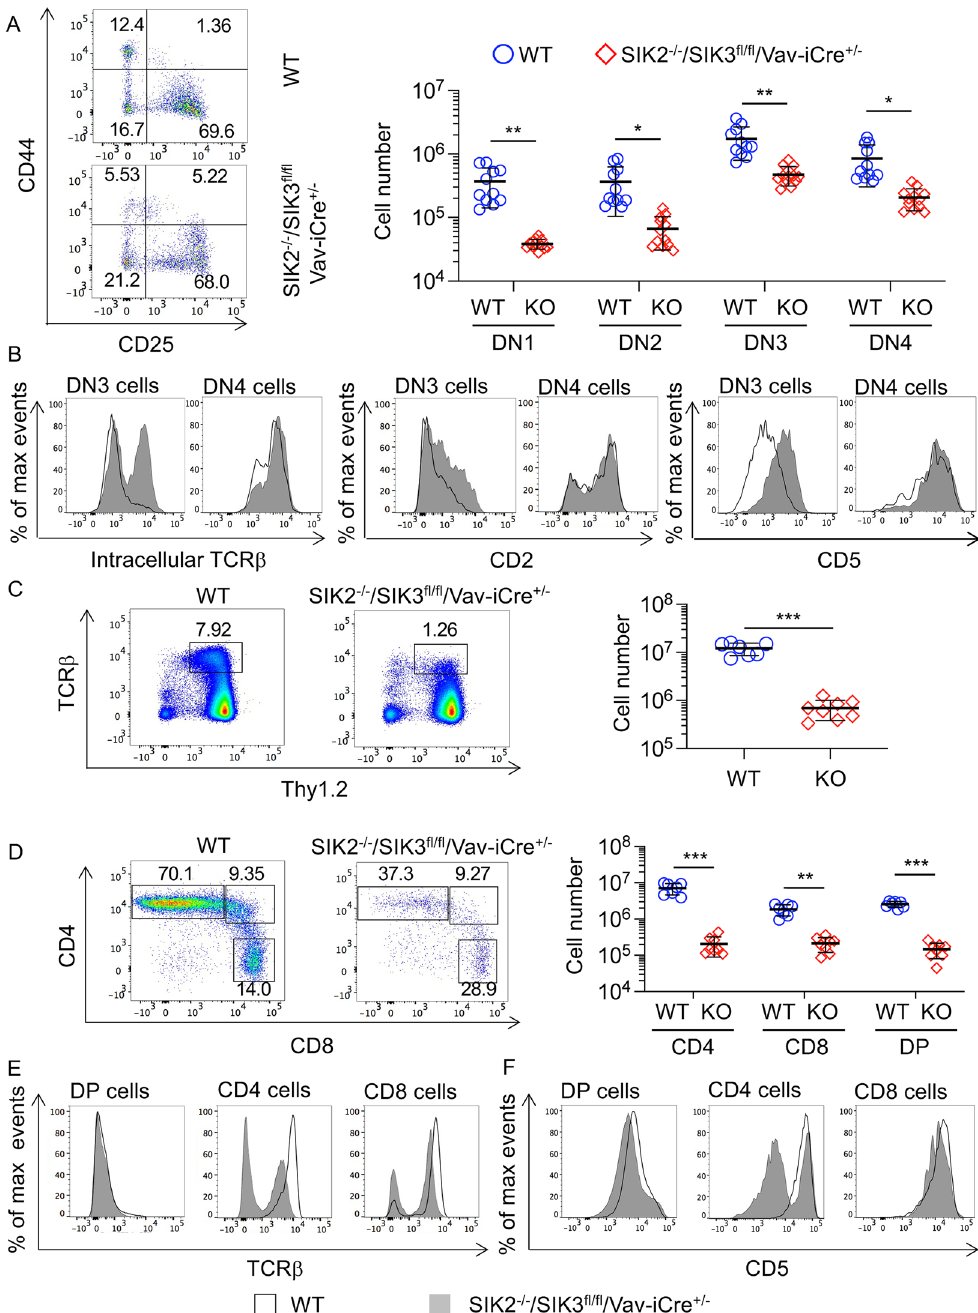
Figure 6. Thymic T cell development is compromised in SIK2 -/- /SIK3 fl/fl /Vav-iCre +/- mice. Thymi were isolated from wild type (WT) and SIK2 -/- /SIK3 fl/fl /Vav-iCre +/- (KO) mice and analysed by flow cytometry. To identify DN cell subsets, Thy1.2 +ve CD4 -ve CD8 -ve cells were gated and analysed for CD25 and CD44 expression. Representative FACS plots and absolute numbers of the different DN subsets (n = 11 for WT and n = 12 for knockouts) are shown in ( A ). Intracellular staining for TCRβ and cell surface expression of CD2 and CD5 in DN3 (Thy1.2 +ve CD4 −ve CD8 −ve CD44 −ve CD25 +ve ) and DN4 (Thy1.2 +ve CD4 −ve CD8 −ve CD44 −ve CD25 −ve ) cells is shown in ( B ). Thymocytes were also analysed for expression of cell surface TCRβ. Representative plots of Thy1.2 vs TCRβ in live thymocytes along with quantification of TCRβ high cells is shown in ( C ). Analysis of CD4 and CD8 expression in the TCRβ high cells is shown in ( D ). For C and D, n = 7 for WT and n = 8 for knockouts. Representative histograms for cell surface expression of TCRβ and CD5 in DP, CD4 and CD8 SP cells are shown in ( E and F ). Graphs show mean with symbols representing measurements from individual mice. Differences in cell number between wild type and knockout mice were analysed by Student’s t-test. p < 0.05 is indicated by *, < 0.01 by ** and < 0.001 by